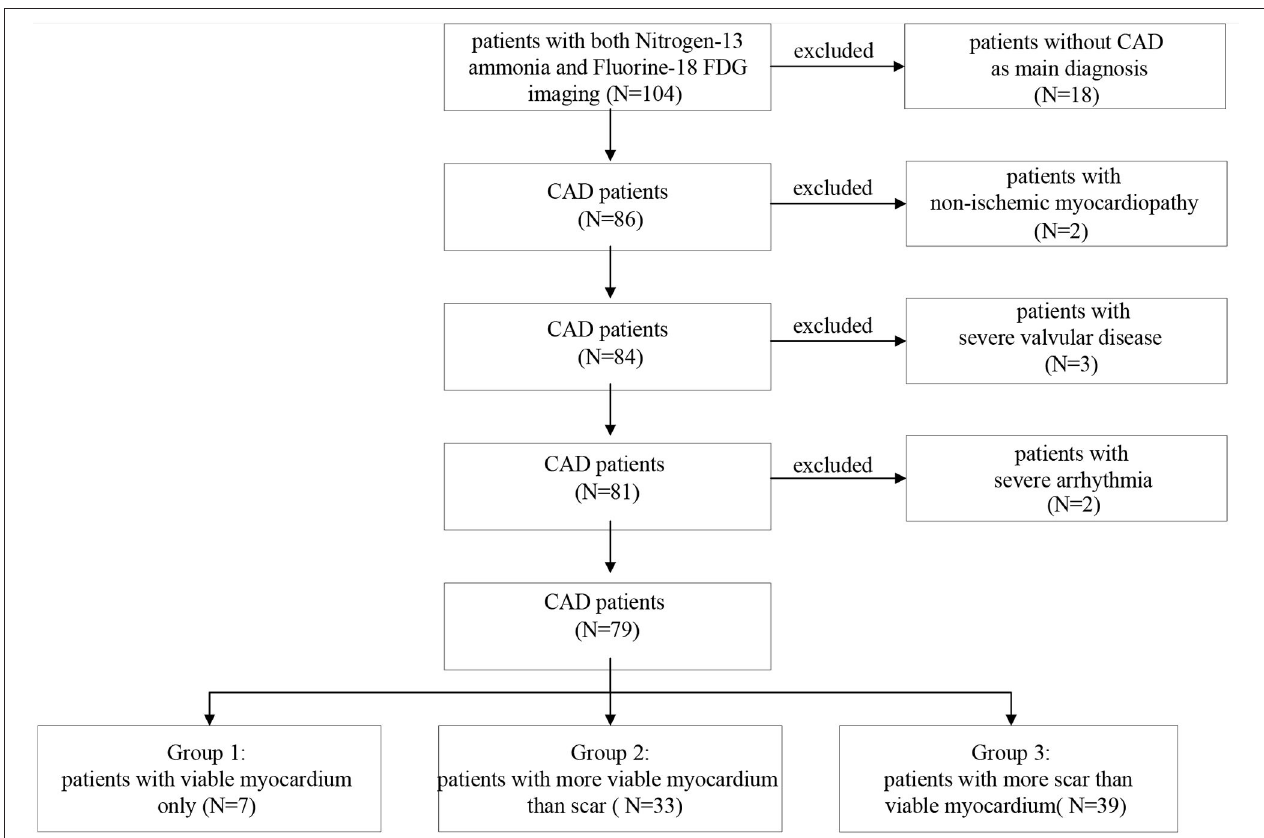
FIGURE 1 | Screening and grouping process of patients with coronary artery disease (CAD).